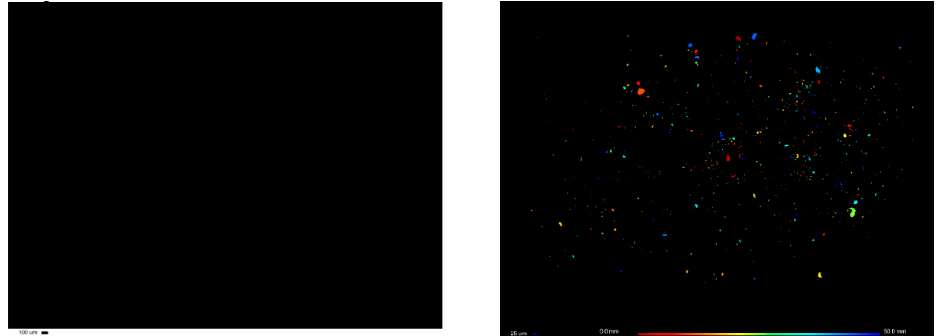
Figure 11. Comparison of hologram processing with reduced (left) and extended (right) settings.